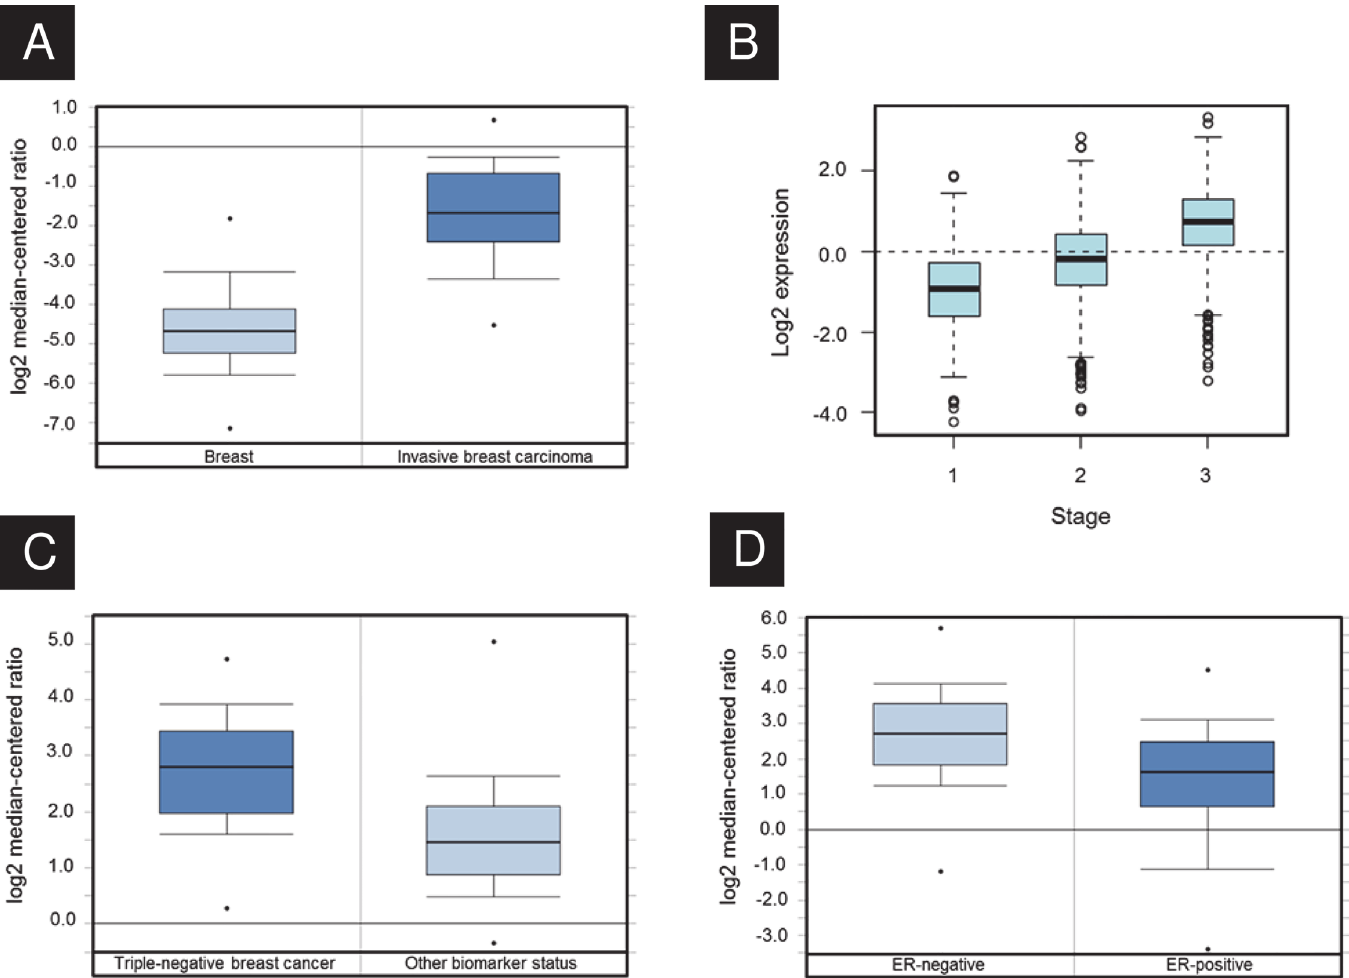
Fig 1. Survivin expression in breast cancer from public databases. A) Survivin expression is approximately seven-fold higher in invasive breast carcinoma compared to normal breast (p = 5.5e-31) from the TCGA data set in the Oncomine public database. B) From the GOBO public dataset, survivin expression increases with breast cancer stage (p < 0.00001). C) Survivin is expressed 2.3-fold higher in triple-negative breast cancer compared to all other molecular subtypes (p = 3.5e-8) in the Bittner breast data set in Oncomine. D) Similarly, survivin expression is 2.3-fold higher in estrogen receptor-negative compared to estrogen receptor-positive breast cancers (p = 9e-46) in the Curtis breast data set [24] in Oncomine.